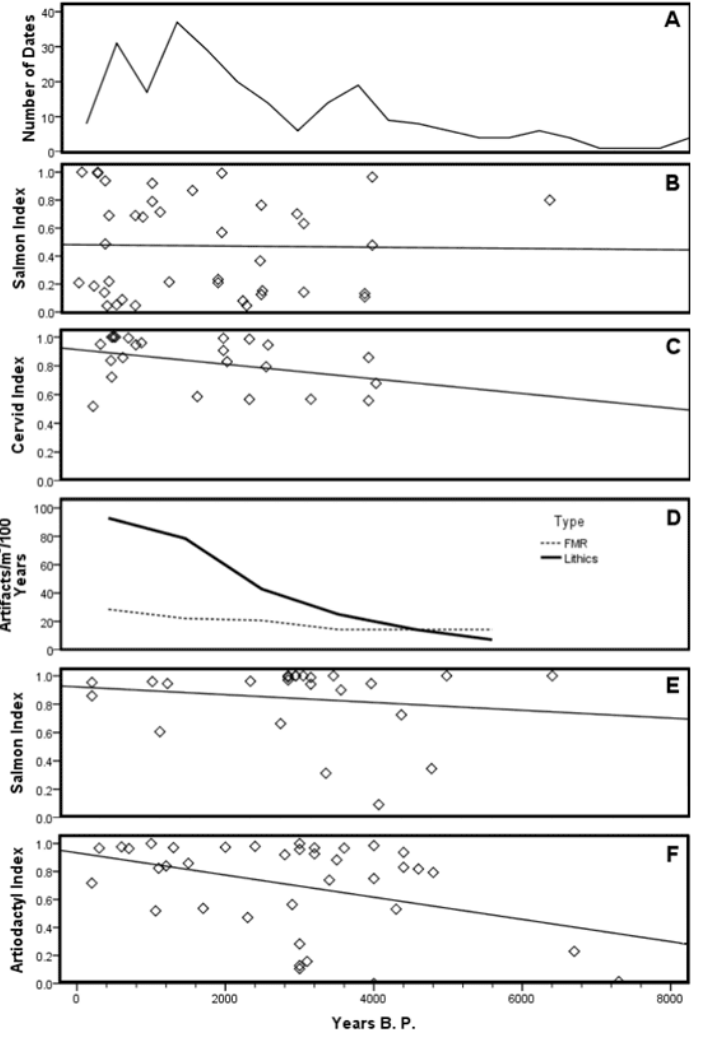
Fig. 2. (A) Plot of radiocarbon dates from southern Northwest Coast archaeological sites, used as a proxy for human population size (adapted from Ames and Maschner 1999: Fig. 4a, summing dates by 400-year intervals); (B) Salmon Index, south–central Northwest Coast sites; (C) Cervid Index, south– central Northwest Coast sites; (D) Artifact accumulation, northern Columbia Plateau archaeological sites, used as a proxy for human population size (adapted from Miss 1985: Fig. 9-6, total artifacts/ volume/duration of components, averaged for all components; FMR—fire-modified rock; Lithics— stone tools and manufacturing debris); (E) Salmon Index, northern Columbia Plateau; (F) Artiodactyl Index, northern Columbia Plateau. Time scale is radiocarbon years before present. Indices are ratios with values from 1–0 (e.g., frequency of salmonid bones /frequency of all fish bones; frequency of cervid bones/frequency of cervid + small mammal bones, and so forth). For the salmon index, 1 indicates an assemblage composed exclusively of salmon and 0 lacks salmon remains. See Butler and Campbell (2004) for more